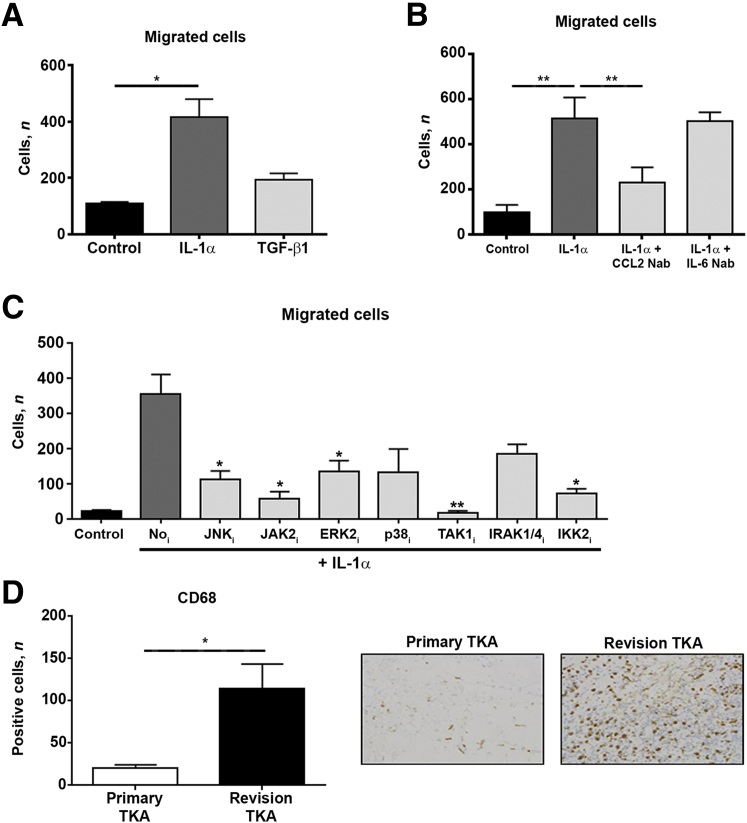
IL-1α–activated fibroblasts promote recruitment of monocytes by secreting CCL2. Fibroblasts isolated from the infrapatellar fat pad of patients undergoing primary total knee arthroplasty (TKA) were stimulated with control media, IL-1α (500 pg/mL), or transforming growth factor (TGF)-β1 (3 ng/mL) for 24 hours to generate conditioned media for transwell migration assays. A: Number of monocytes recruited by conditioned media from unstimulated (control), IL-1α–stimulated, and TGF-β1–stimulated fibroblasts. B: Conditioned medium from IL-1α–stimulated fibroblasts was pretreated for 1 hour with neutralizing antibodies against CCL2 and IL-6 and then used in transwell migration assays. C: Conditioned medium from fibroblasts pretreated for 1 hour with several selective inhibitors (transforming growth factor β–activated kinase, 1 μmol/L; all other inhibitors, 10 μmol/L) before stimulation with IL-1α for 24 hours and then used in transwell migration assays. The number of migrated cells was quantified on a Nikon Eclipse microscope. Data are analyzed using paired t-tests. D: Number of CD68+ cells in the infrapatellar fat pad of patients undergoing primary and revision TKA was quantified in 10× randomly selected high-powered fields using Nikon NIS elements image analysis software. Data are analyzed using U-test. Data are presented as means ± SEM (C and D). n = 6 (A–C). ∗P < 0.05, ∗∗P < 0.01 versus Noi. Original magnification, ×20 (D). ERK, extracellular signal–regulated kinase; IKK, Iκ B kinase; IRAK, IL-1 receptor associated kinase; JAK, Janus activating kinase; JNK, c-Jun N-terminal kinase.